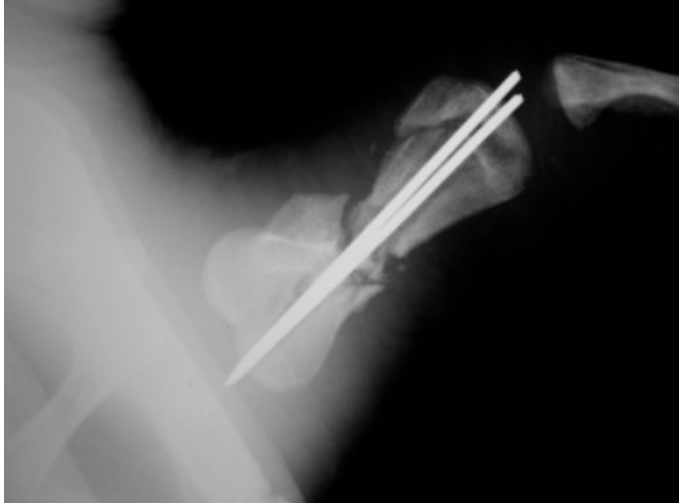
Figure 4. Two-month follow-up performed in caudocranial view of the anterior right flipper showing the filling of the diaphyseal fracture line .